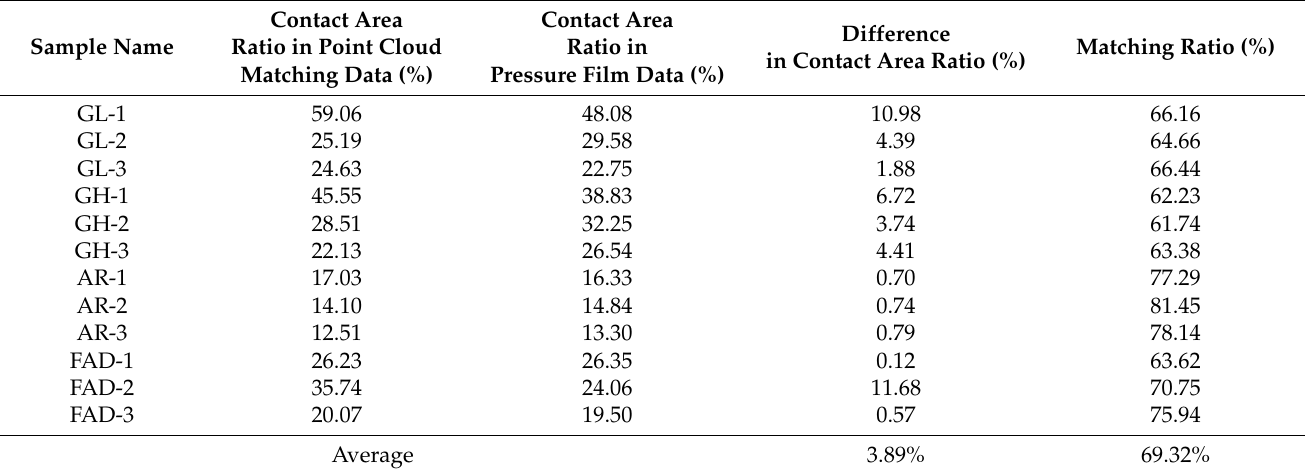
Table 2. Analysis result of matching ratio and contact area for natural fracture